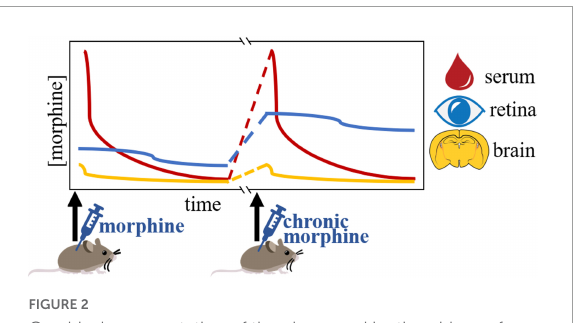
FIGURE2 Graphical representation of the pharmacokinetic evidence for a retinal contribution to chronic opioid-induced sleep/wake disturbances (as presented in Bergum et al., 2022). Morphine levels in the retina appear to accumulate following chronic systemic exposure, while levels in both the serum and hypothalamus remain the